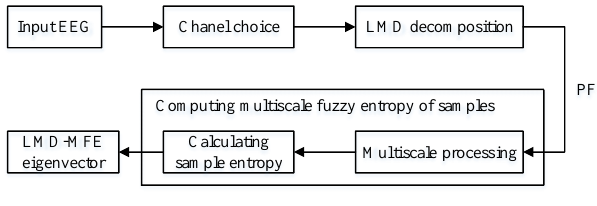
Figure 2. EEG feature extraction